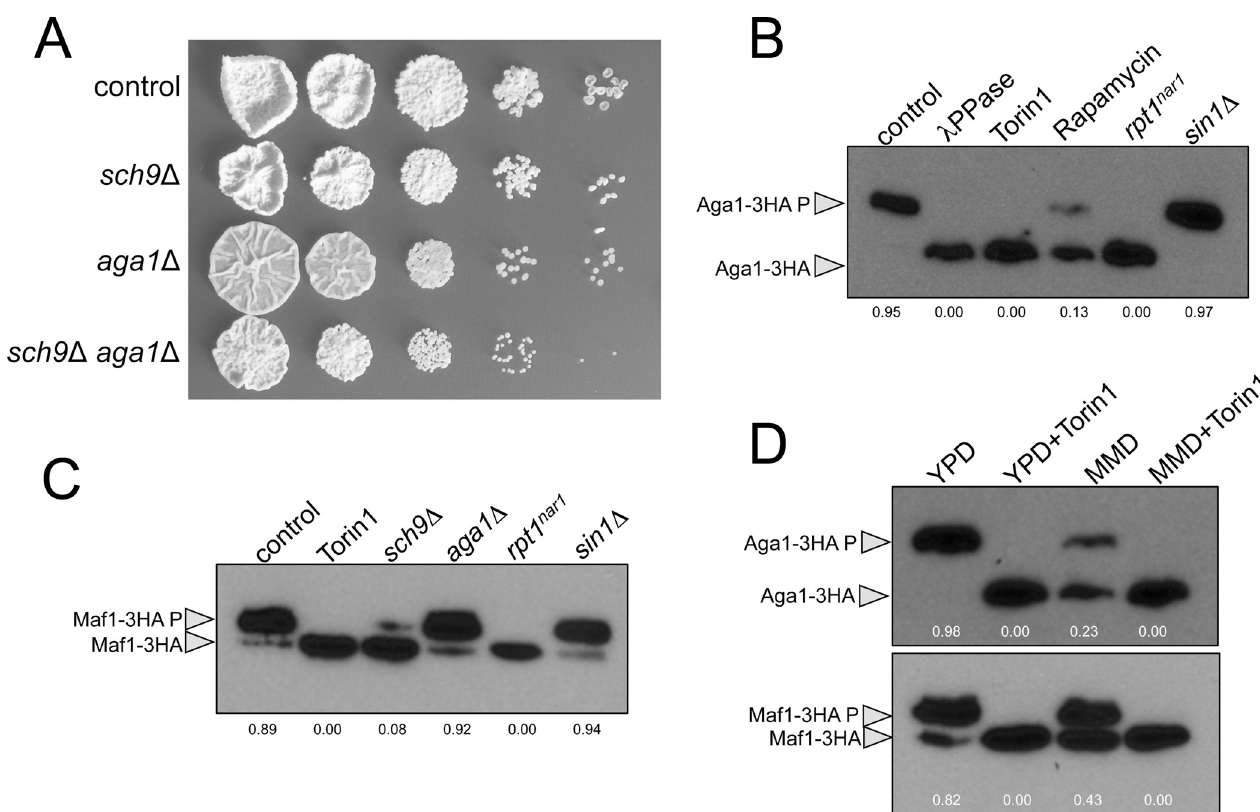
Fig 2. TORC1 signals through two AGC kinases in U . maydis . (A) Loss-of-function alleles for AGC kinases. Serial tenfold dilution of cultures from strains carrying the indicated deletion alleles (control: FB1), spotted in solid YPD medium. Plates were incubated for 3 days at 28˚C. (B) TORC1-dependent phosphorylation of Aga1. Anti-HA immunoprecipitates of cell extracts from cultures of cells carrying an endogenous Aga1 HA-tagged allele grown for 8 hours in YPD were incubated at 30˚C for 20 min in the absence (control) or presence ( λ PPase) of lambda protein phosphatase. They were then separated in Phos-tag gels and subjected to immunoblot analysis with anti-HA. The gel also showed anti-HA immunoprecipitates of cell extracts from cultures of control cells grown in YPD amended with 10 μ M Torin1 and 1 μ g/ml rapamycin and cultures from the indicated mutant strains, also grown 8 hours in YPD. Numbers below each gel lane indicated the ratio between the phosphorylated and unphosphorylated bands and results from the average of three independent western assays. (C) TORC1-dependent phosphorylation of Maf1. Anti-HA immunoprecipitates of cell extracts from cultures of cells carrying an endogenous Maf1 HA-tagged allele and the indicated mutations grew for 8 hours were separated in Phos-tag gels and subjected to immunoblot analysis with anti-HA. Control cultures were also incubated with 10 μ M Torin1. Numbers below each gel lane indicated the ratio between the phosphorylated and unphosphorylated bands and results from the average of three independent western assays. (D) TORC1-dependent phosphorylation and nutritional conditions. Western blot anti-HA immunoprecipitates from cell extracts obtained from cultures of cells carrying an endogenous Maf1 or Aga1 HA-tagged allele incubated for 8 hours in YPD or nitrate minimal medium (MMD) with or without the addition of 10 μ M Torin1. Numbers below each gel lane indicated the ratio between the phosphorylated and unphosphorylated bands and results from the average of three independent western assays.